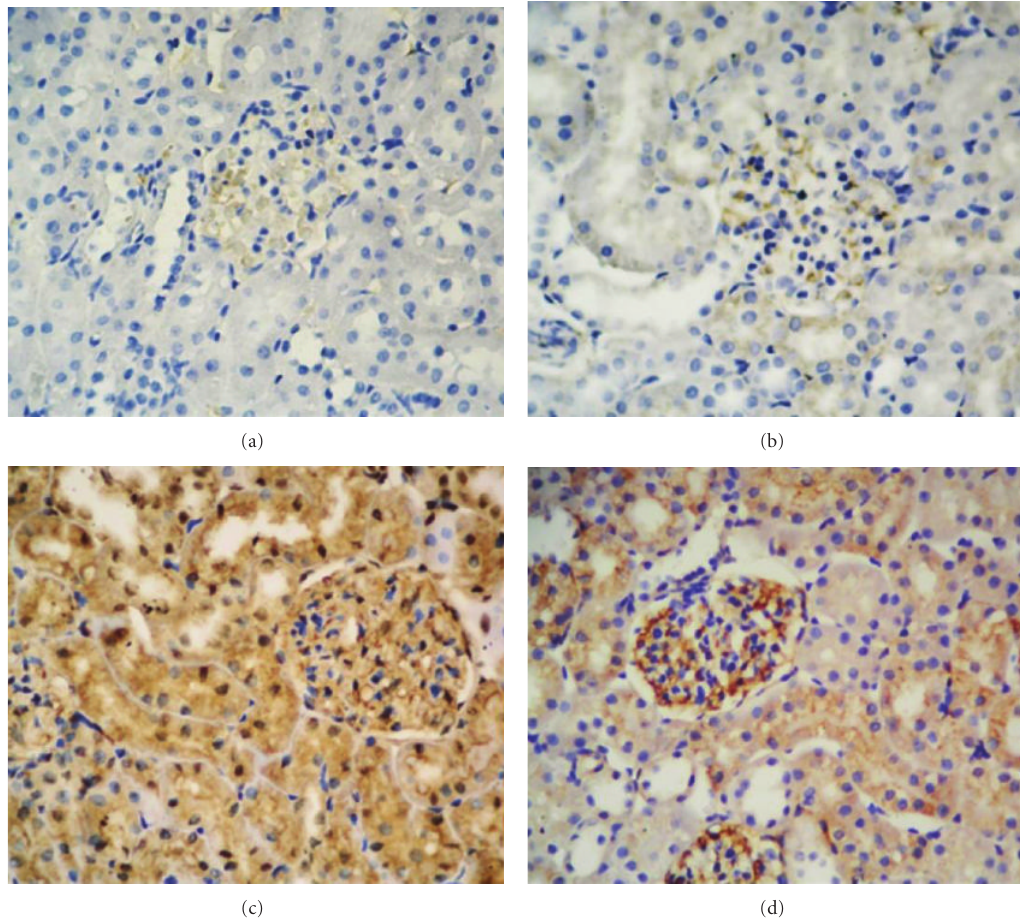
Figure 6: (a) and (b) eNOS control and nicotinamide (NAD), (c) doxorubicin (DXR), (d)